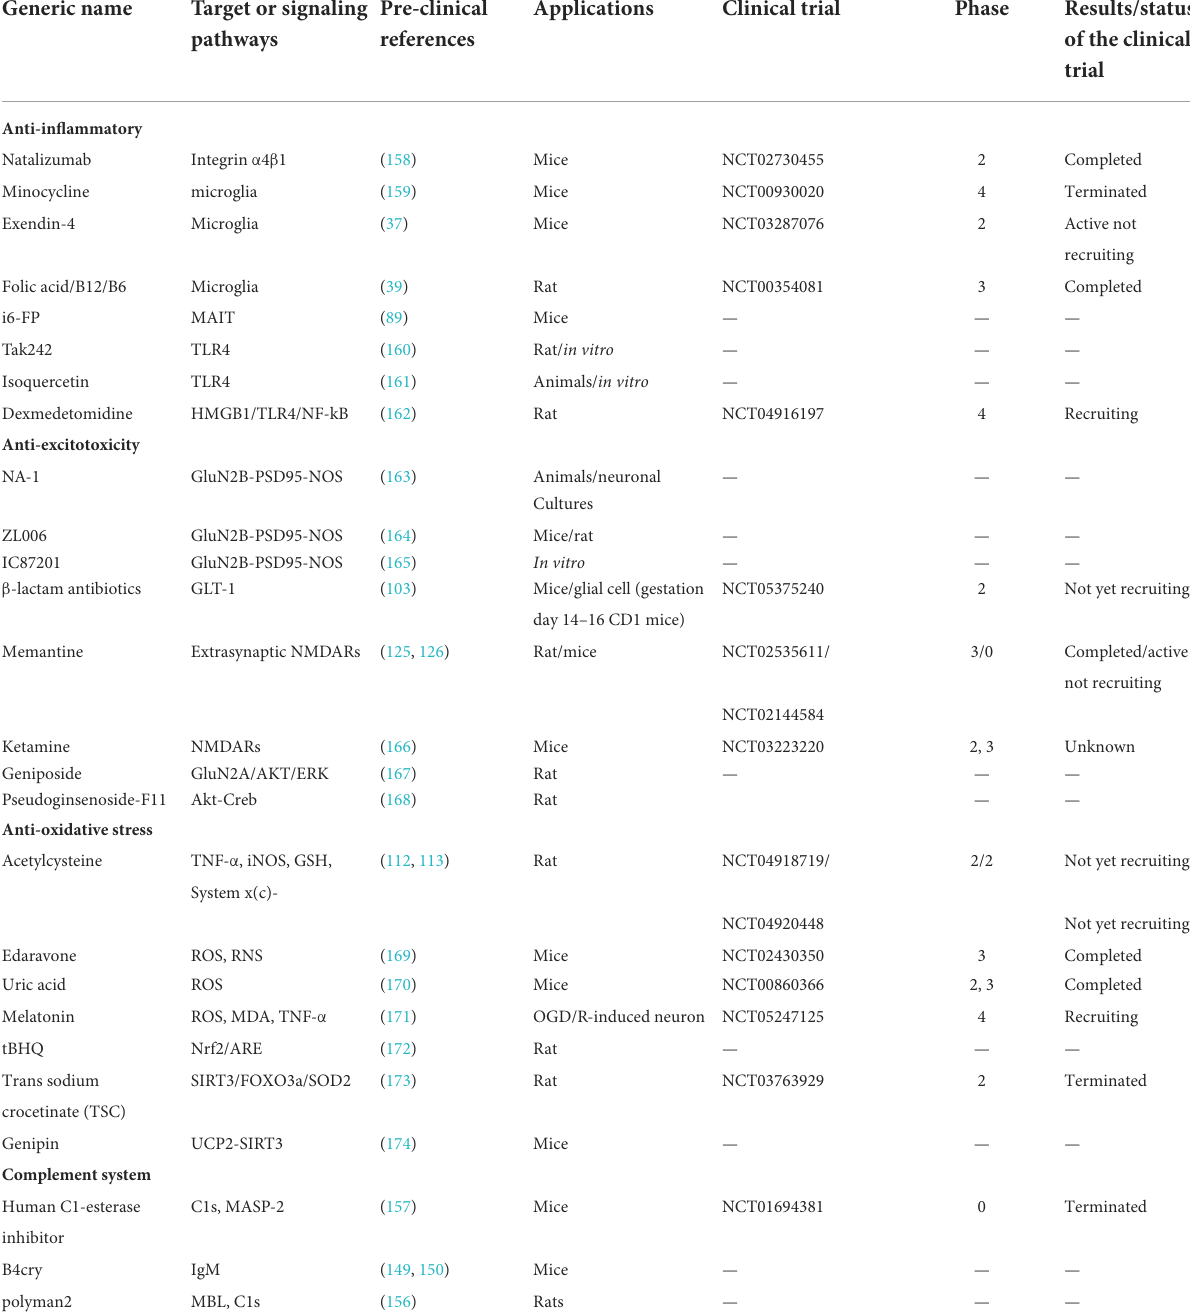
TABLE 1 Clinical trials and pre-clinical studies of